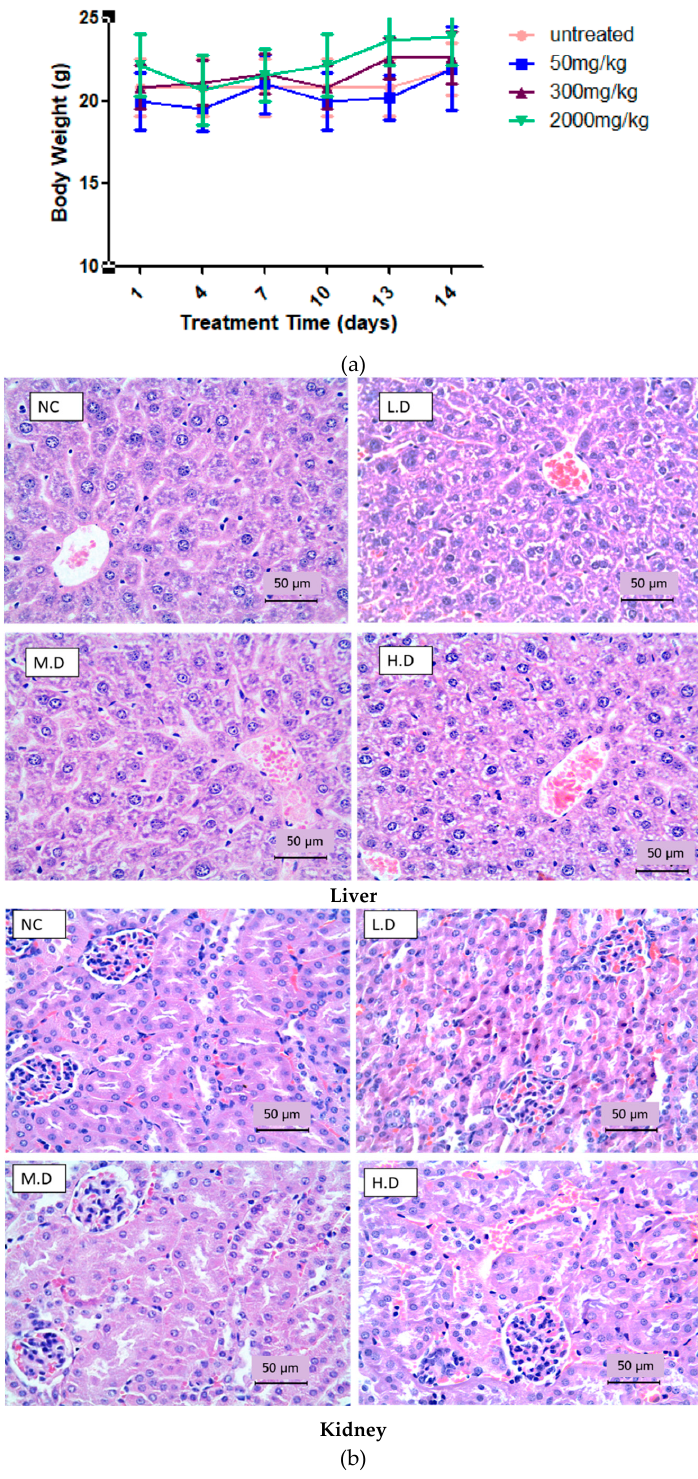
Figure 1. Acute toxicity study of cardamonin ( a ) Body weight changes of CADMN-treated groups and untreated group for 14 days in female ICR mice. Data were expressed as mean ± standard deviation. ( b ) Histology sections of liver and kidney in control and CADMN-treated ICR mice. Animals were observed after a single oral dose for 14 days. Hematoxylin and Eosin staining were applied on liver and kidney tissues after harvesting. Toxicity signs were absence in the liver and kidney histological samples. Magnification 40 × , NC: negative control, LD: low dose (50 mg / kg), MD: moderate dose (300 mg / kg) and HD: high dose (2000 mg /